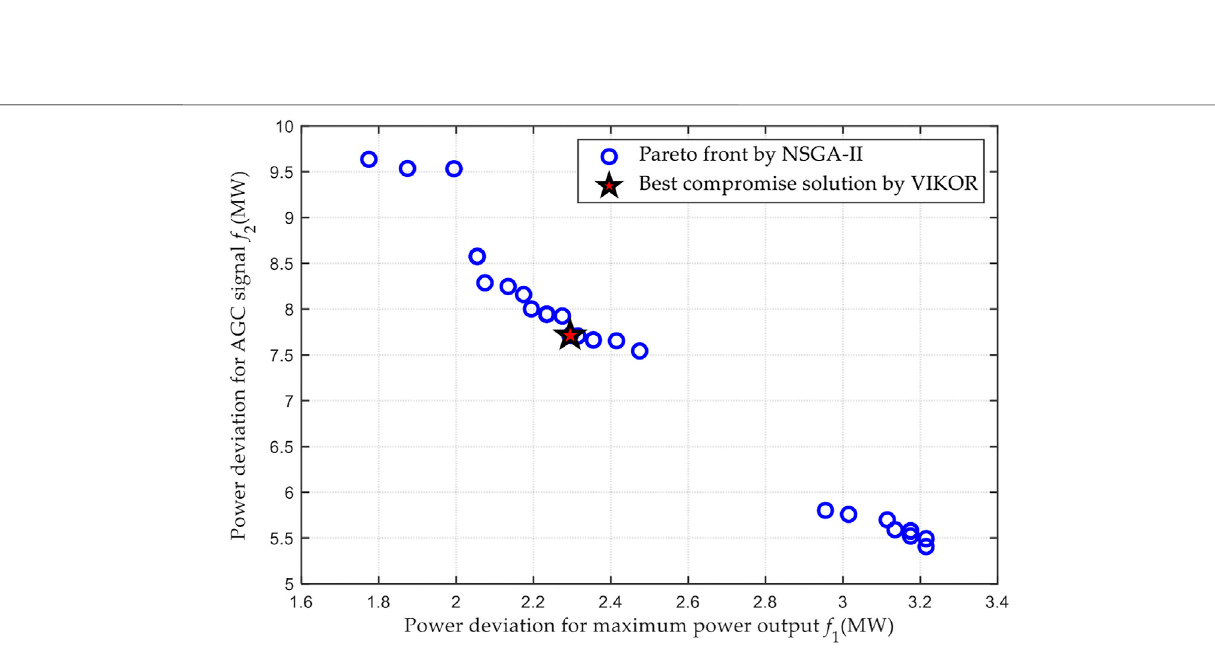
FIGURE 10 | Optimal Pareto front by NSGA-II and best compromise solution by VIKOR on the varying AGC signals.